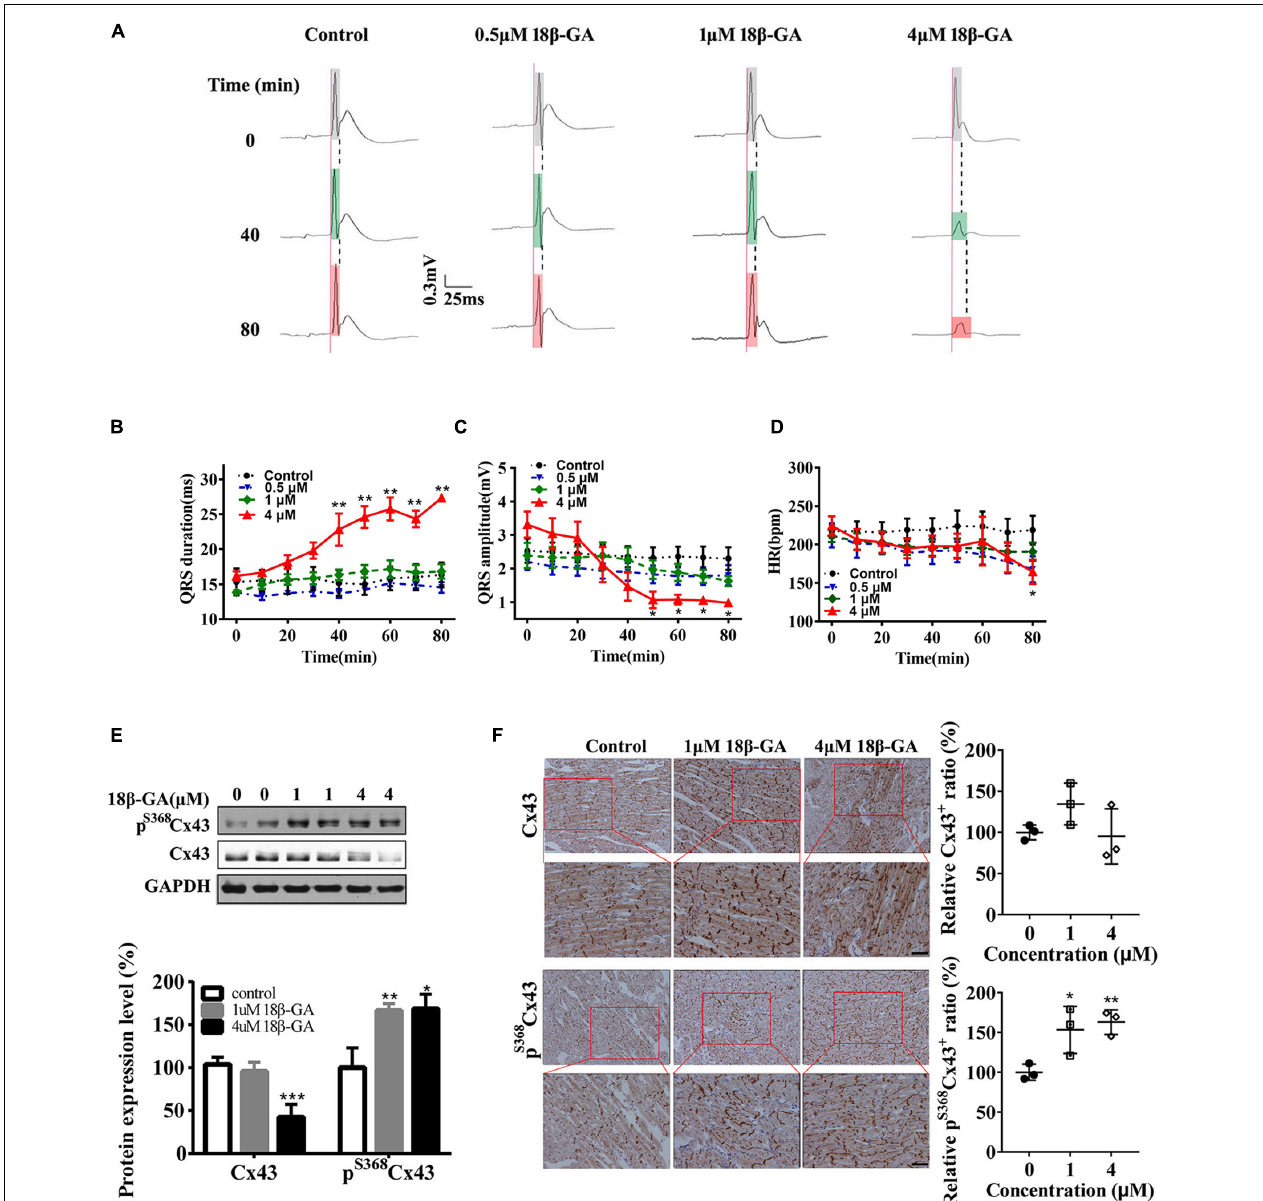
FIGURE 3 | Cx43 hyperphosphorylation and lateralization induced by 18 β -GA produce an abnormal QRS complex. (A) 18 β -GA (0.5, 1, and 4 µ m) perfusion (80 min) produced abnormal QRS duration of isolated rat hearts. Light gray box: QRS duration of isolated heart after stabilization; light green box: QRS duration of isolated heart after 40-min of perfusion; light red box: QRS duration of isolated heart after 80-min of perfusion. (B–D) Statistical data changes of QRS duration, QRS amplitude, and HR. n = 5 for each group. (E) Western blot images of pS368Cx43 and Cx43 in the control and 18 β -GA-treated rats’ cardiac ventricles. The level of pS368Cx43 and Cx43 was normalized to GAPDH. (F) Immunohistochemical analysis of Cx43 and pS368Cx43 expression and redistribution (Bar = 20 µ m), and corresponding statistical data of Cx43 + and pS368Cx43 + cells ratio. Error bars represent mean ± SD . * p < 0.05 vs. control; ** p < 0.01 vs. control; *** p < 0.001 vs.